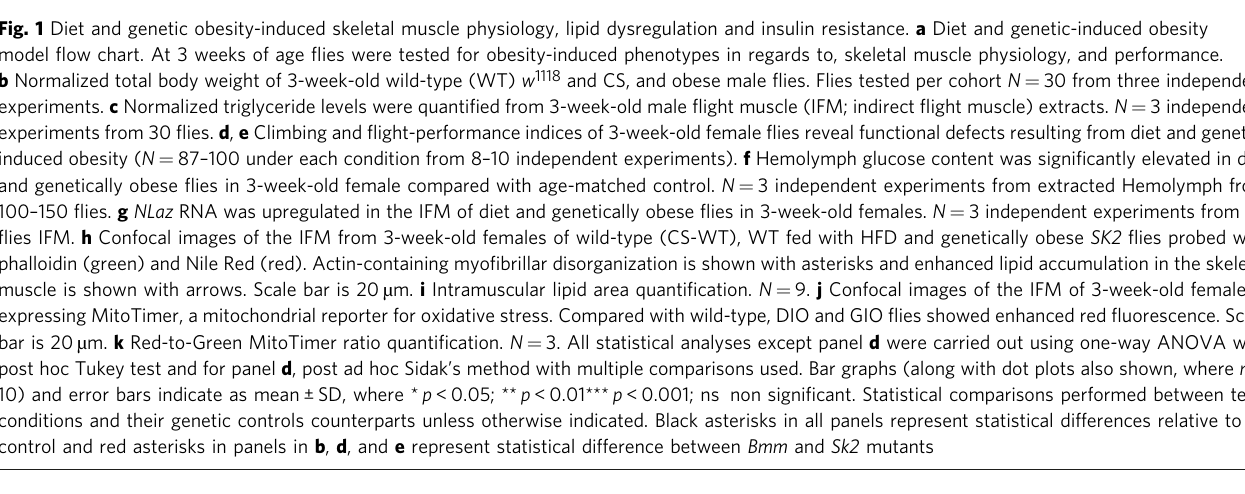
Fig. 1 Diet and genetic obesity-induced skeletal muscle physiology, lipid dysregulation and insulin resistance. a Diet and genetic-induced obesity model fl ow chart. At 3 weeks of age fl ies were tested for obesity-induced phenotypes in regards to, skeletal muscle physiology, and performance. b Normalized total body weight of 3-week-old wild-type (WT) w 1118 and CS, and obese male fl ies. Flies tested per cohort N = 30 from three independent experiments. c Normalized triglyceride levels were quanti fi ed from 3-week-old male fl ight muscle (IFM; indirect fl ight muscle) extracts. N = 3